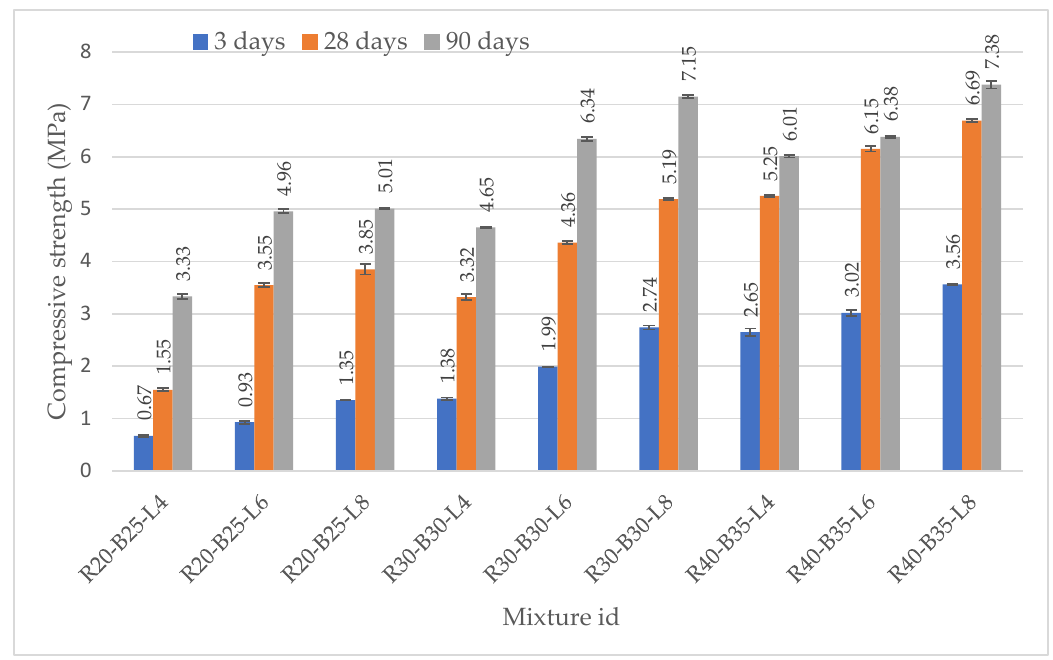
Figure 6. Changes in axial resistance of samples after 3, 28, and 90 days.